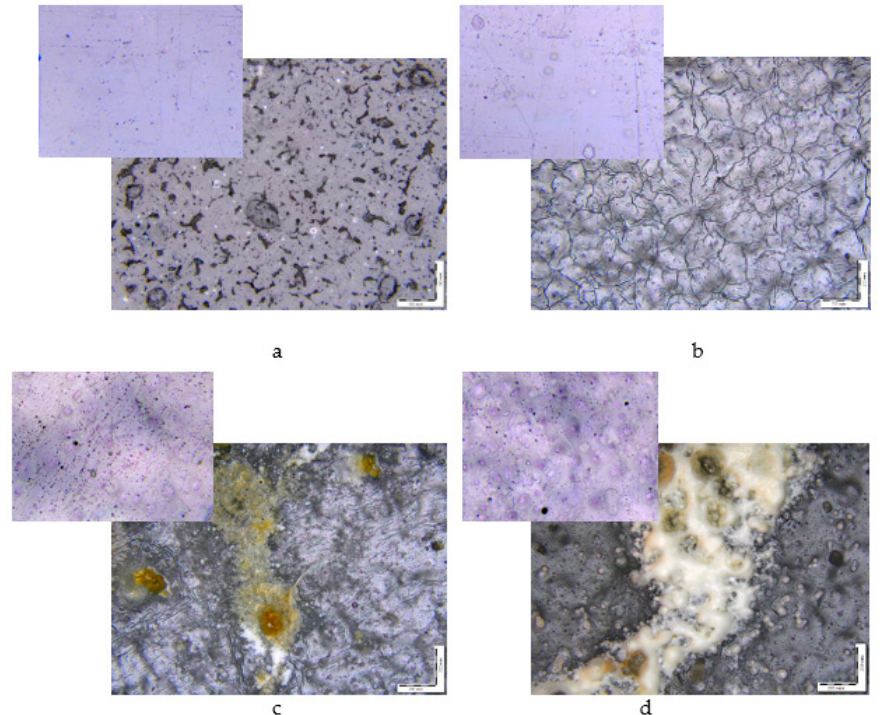
Figure 2. Micrographs of film samples with the NR content after the Sturm experiment, wt.%: ( a ) 0, ( b ) 5, ( c ) 10, ( d ) 15. The insets show the initial films of the same compositions. The magnification is 200×.